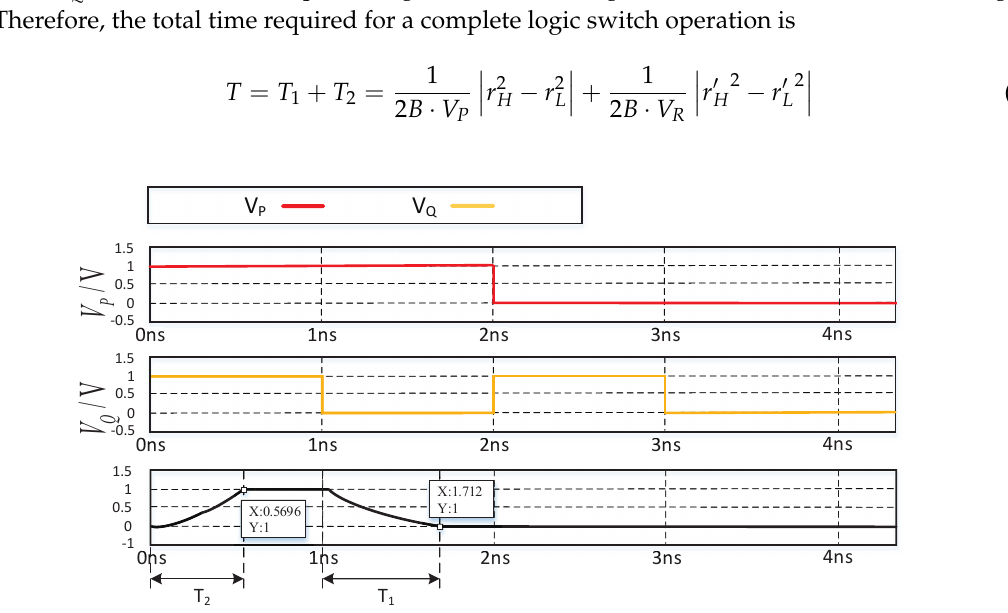
Figure 5. Simulation results of logic switches based on spin